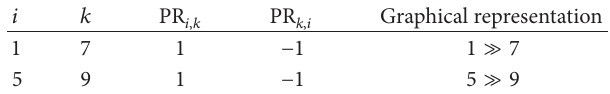
Table 9: Precedence relations among the 10 panel blocks to be con-